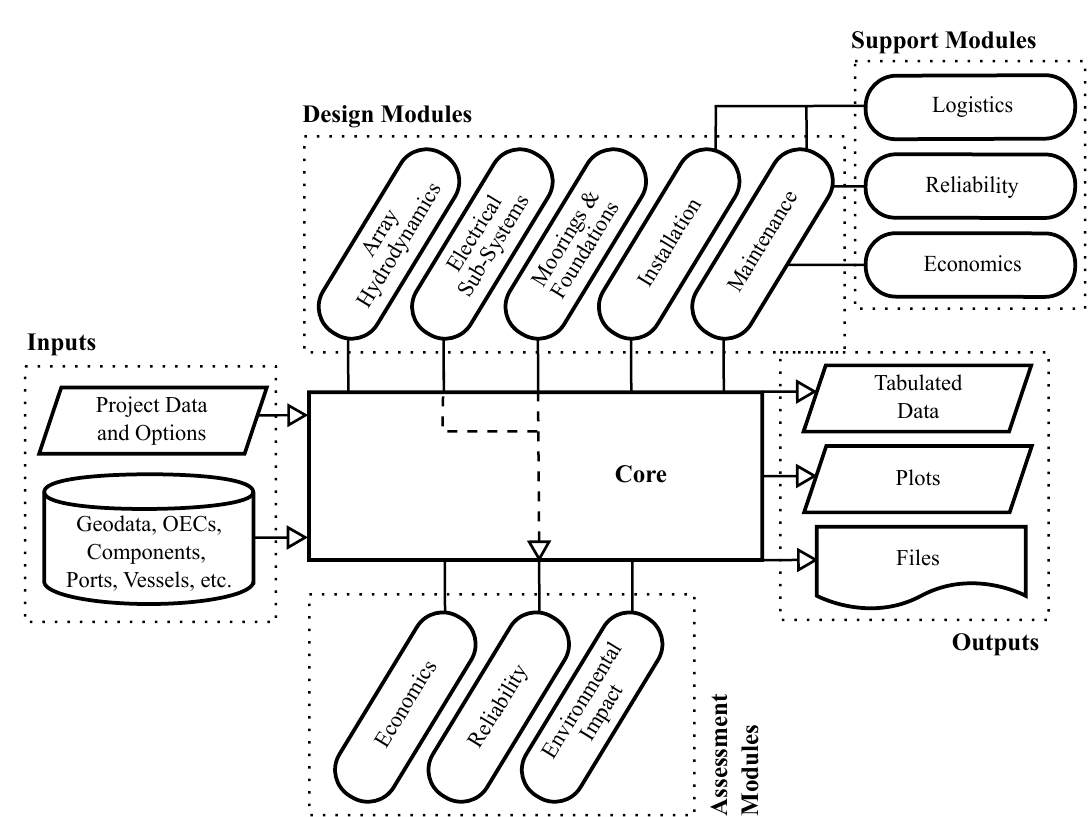
Figure 1. Relationships between the key software elements and user. Data is transferred between the user, database, design and assessment modules by the core. The core also sequences the execution of modules. Support modules provide functionality shared between multiple design or assessment modules, and are accessed directly. Reproduced from